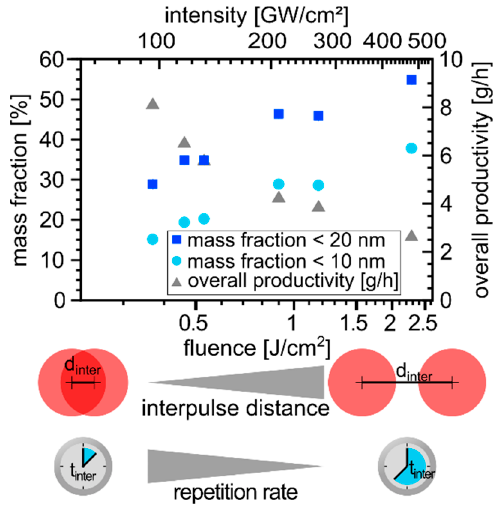
Figure 4. Influence of laser fluence on the mass fraction of Pt NPs < 10 (light blue circles) and < 20 nm (blue squares) and the overall productivity (gray triangles). The sketch below the graph indicates the change in the lateral interpulse distance d inter as well as the repetition rate (inverse temporal interpulse distance t inter ) with changing pulse energy at constant laser power.